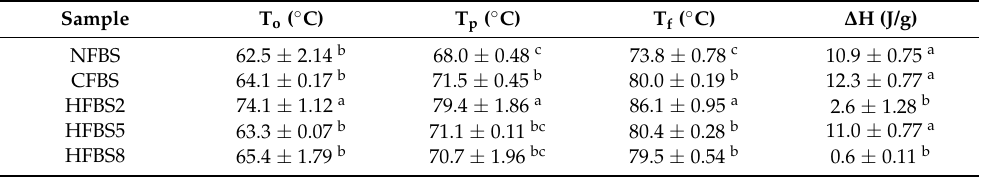
Table 3. Thermal parameters of native and hydrolyzed faba bean starches 1 .